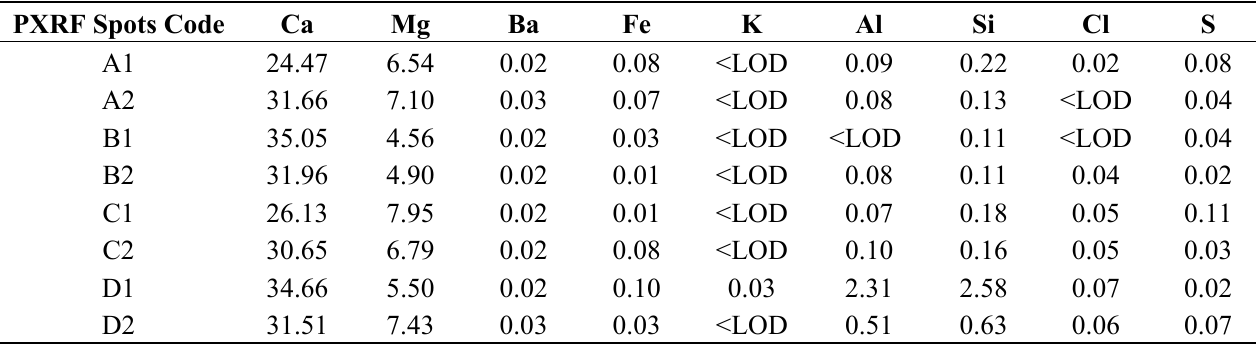
Table 1. Elemental concentrations of the rock samples derived from portable X-ray fluorescence (PXRF) spot measurements (in percent). Some elements have lower limits of detection